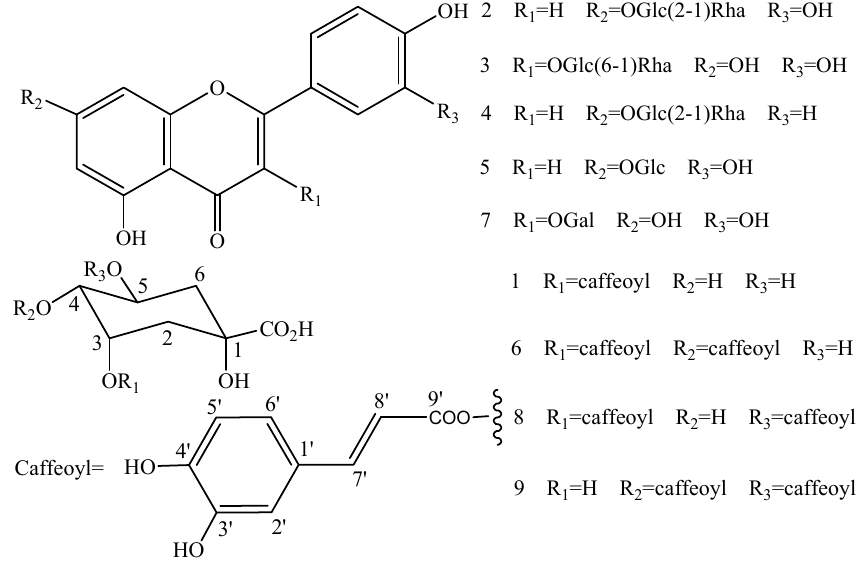
Figure 1. Chemical structures of the nine compounds.